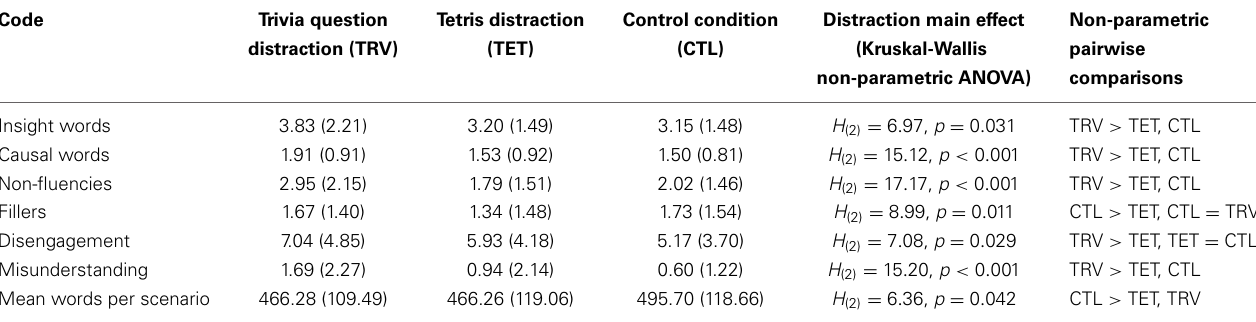
Table 2 | Mean (Standard Deviation) LIWC cognitive processing and spoken category code Scores a and total coder-rated disengagement and misunderstanding for the trivia question (TRV), tetris (TET), and control distraction (CTL)